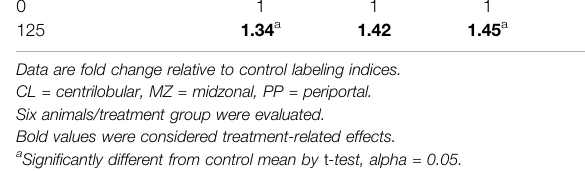
TABLE 3 | Summary of Hepatocellular Proliferation by Lobular Zones in Female B6C3F1 Mice Treated with 0 or 125 mg/kg/day Nitrapyrin for 4 days.